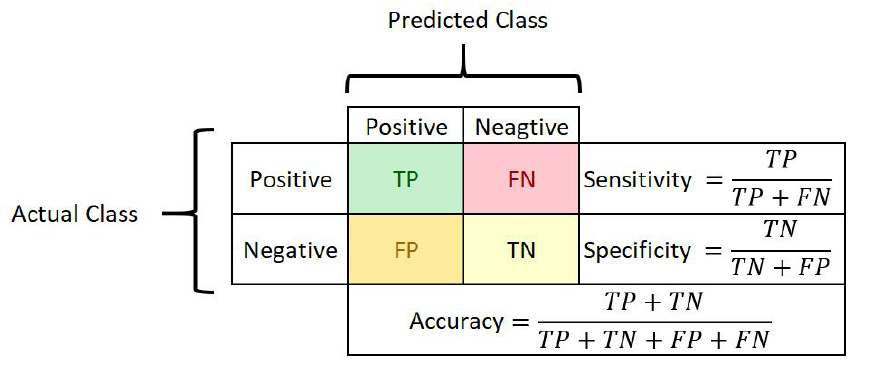
Figure 12. Confusion